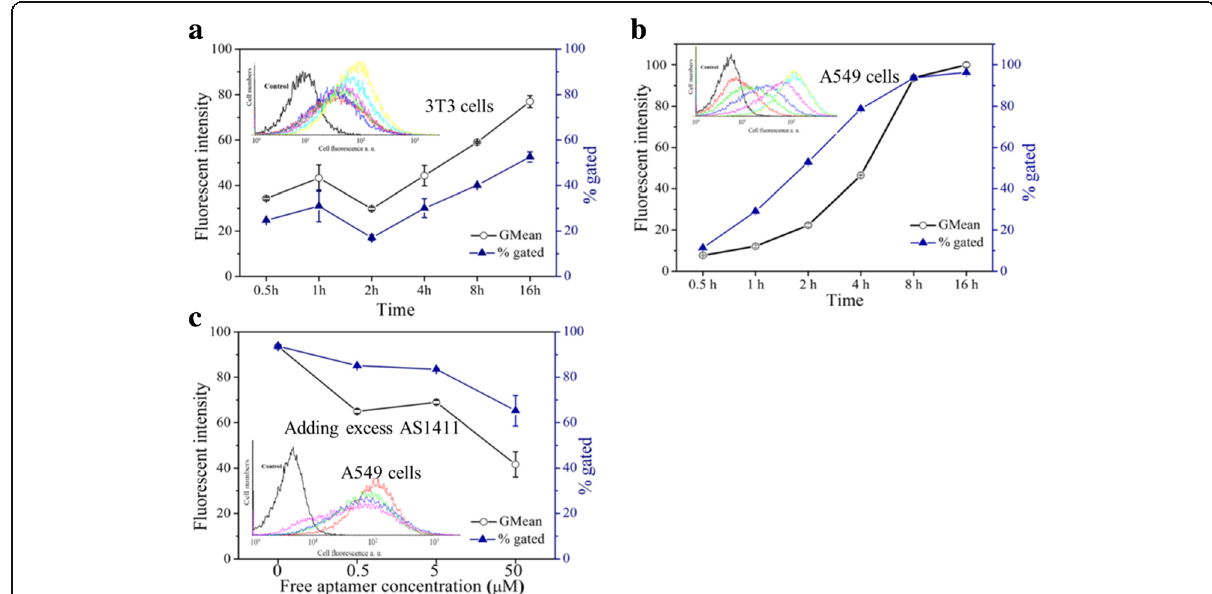
Fig. 6 Flow cytometry analysis (FCMS) of cell uptake of FAM-labeled Apt-GS and TDO-GS nanogels in different cell types. Insert: FACS profiles, a , b curve red, green, blue, purple, aqua, and yellow present the incubation time from 0.5 to 16 h; c curve red, green, blue, and purple mean the concentration of AS1411 from 0 to 16 μ M